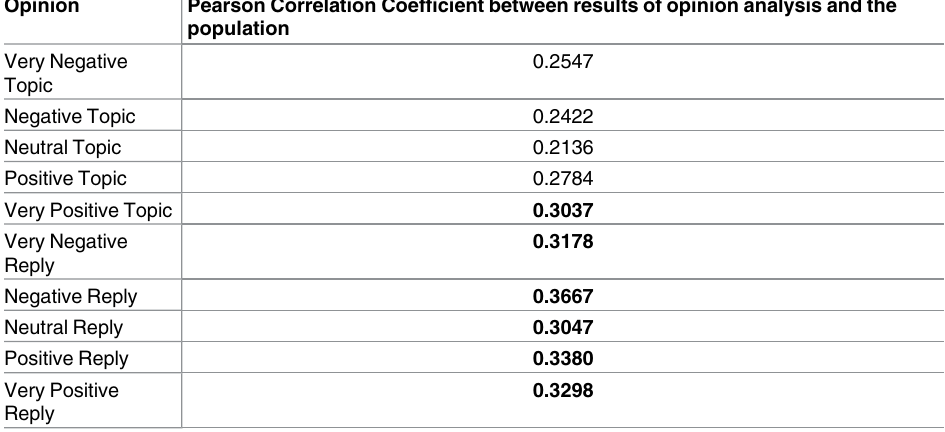
Table 3. Pearson Correlation Coefficient Result